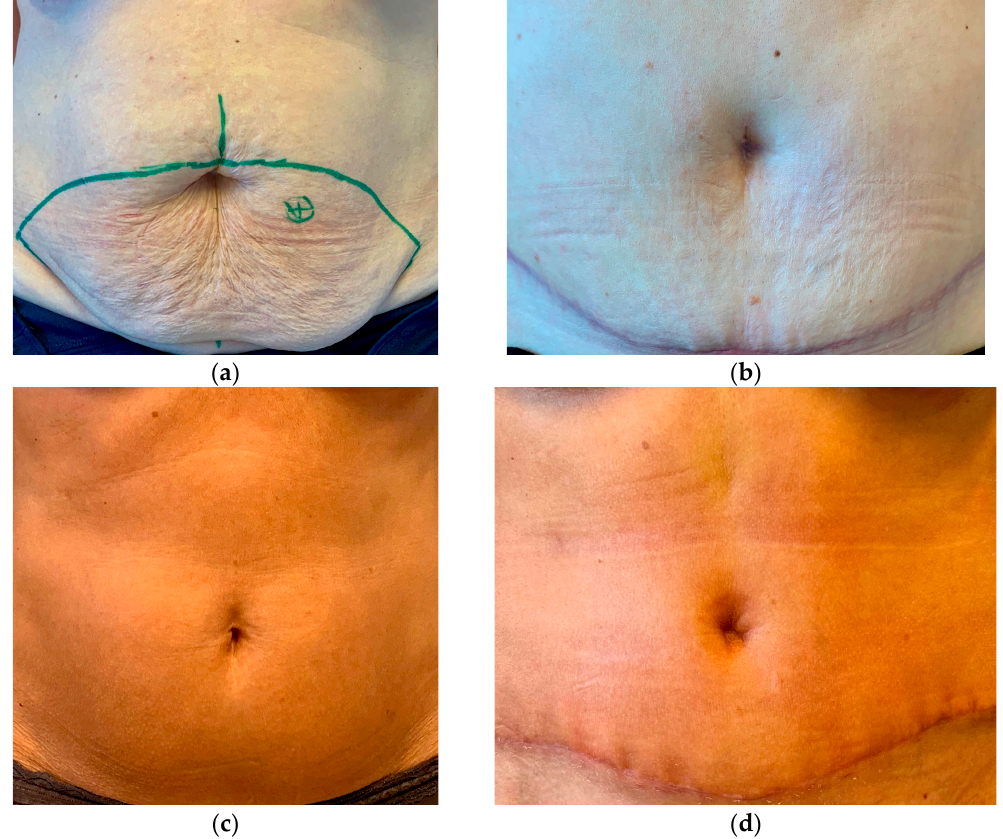
Figure 3. ( a , b ) Patient pre-( a ) and postoperative ( b ) after neo-umbilicoplasty. ( c , d ) Another patient pre-( c ) and postoperative ( d ).